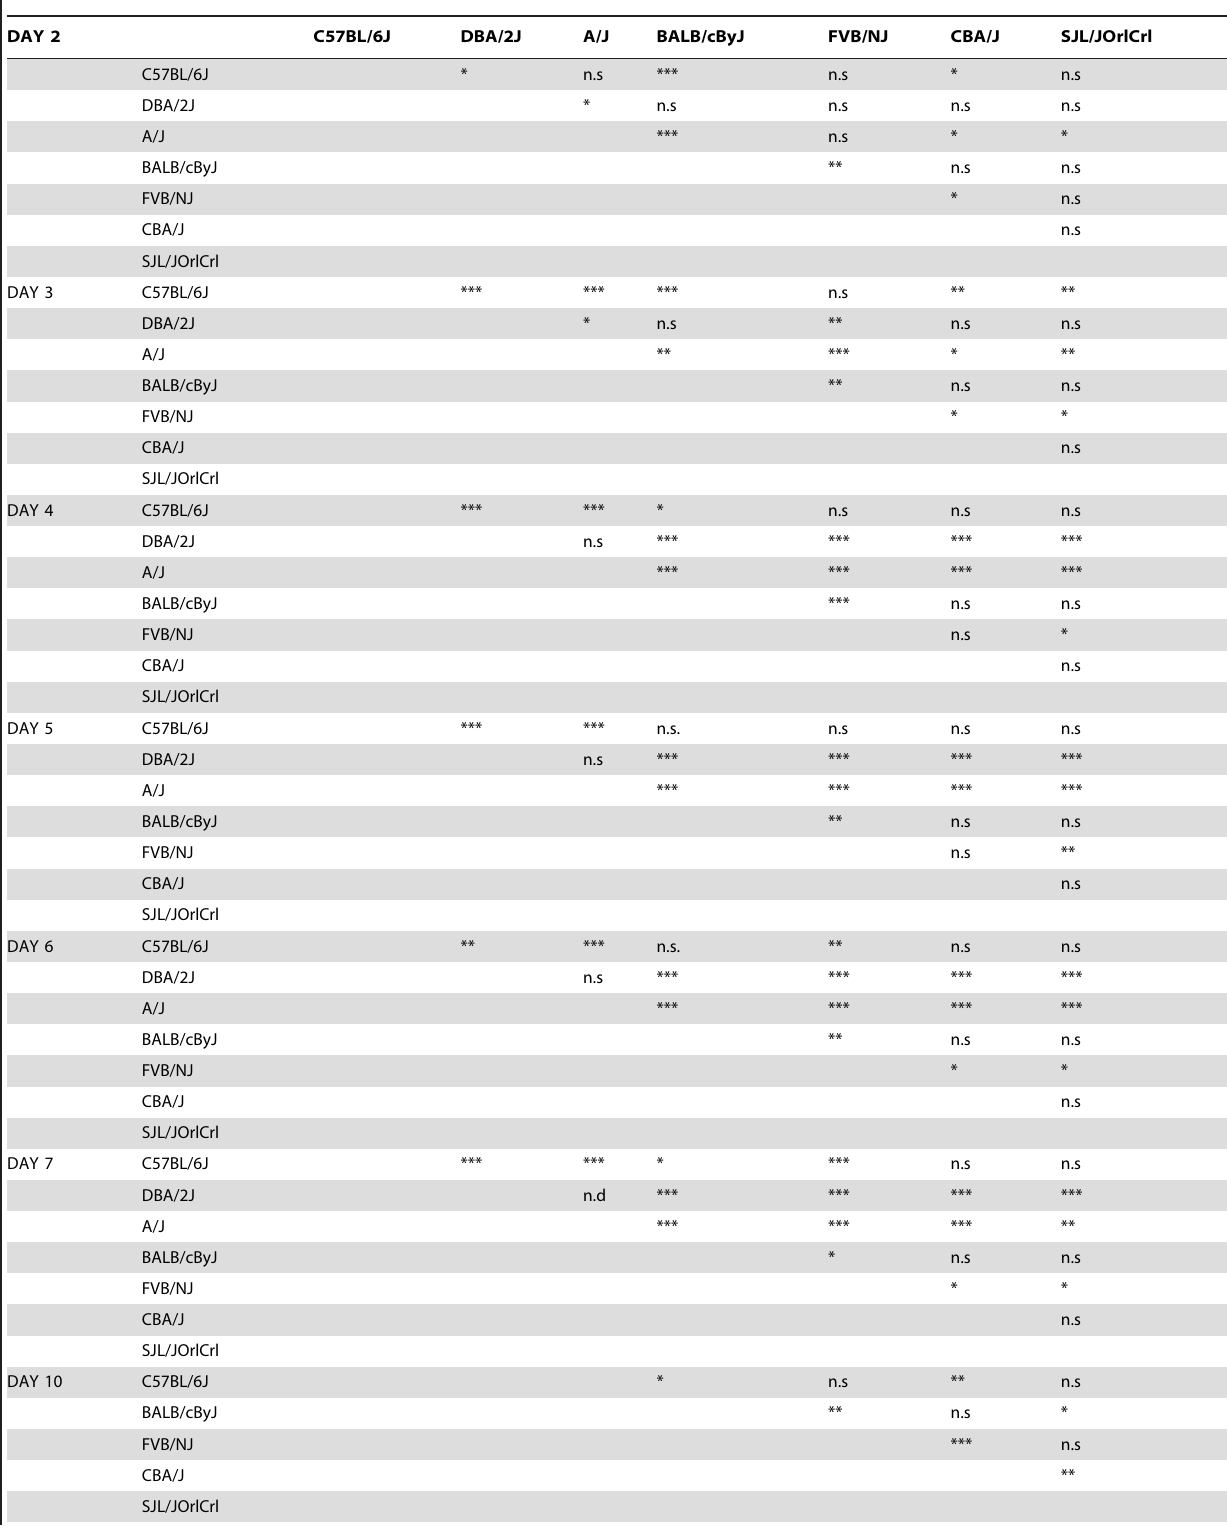
Table 1. Pair wise statistical comparison of all mouse strains presented in figure 1.